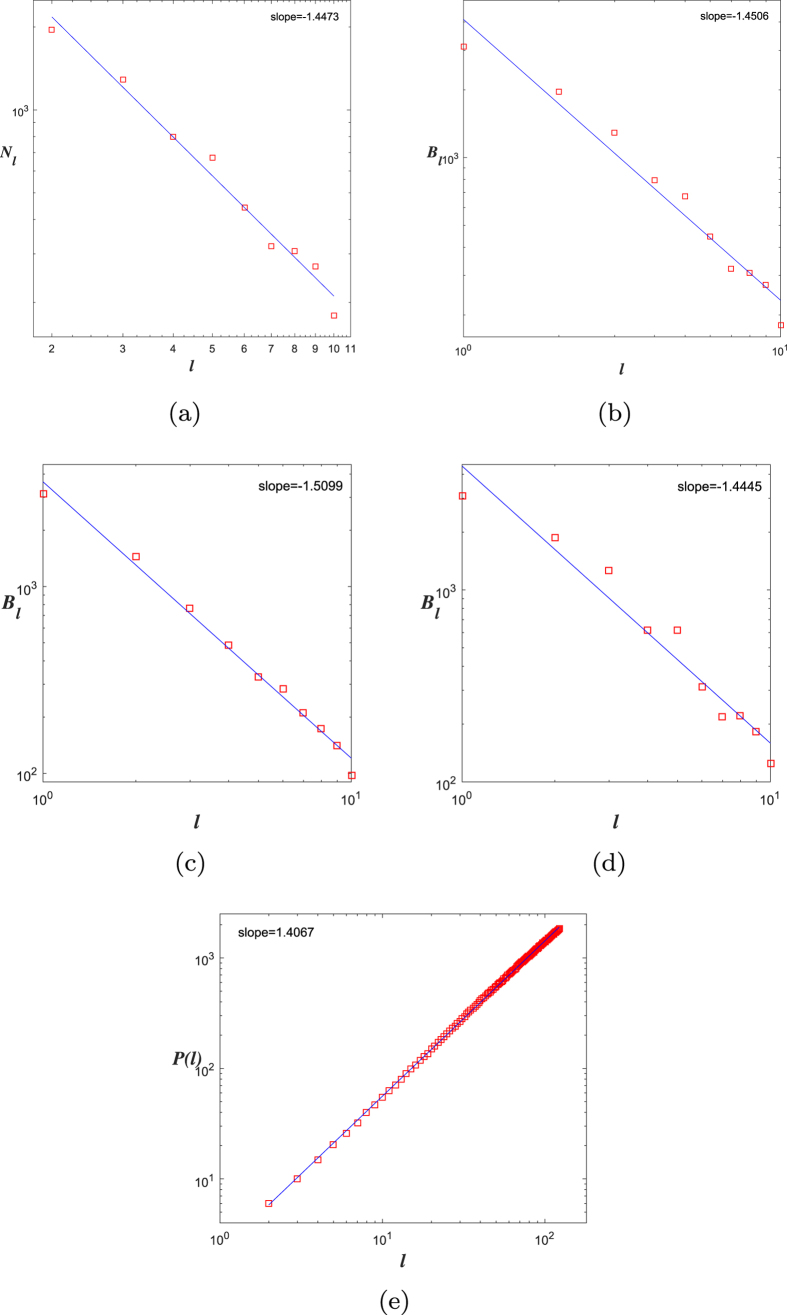
Fractal dimensions of G5: (a) CBB, (b) RBC, (c) DGBC, (d) DOBC, (e) RBV.